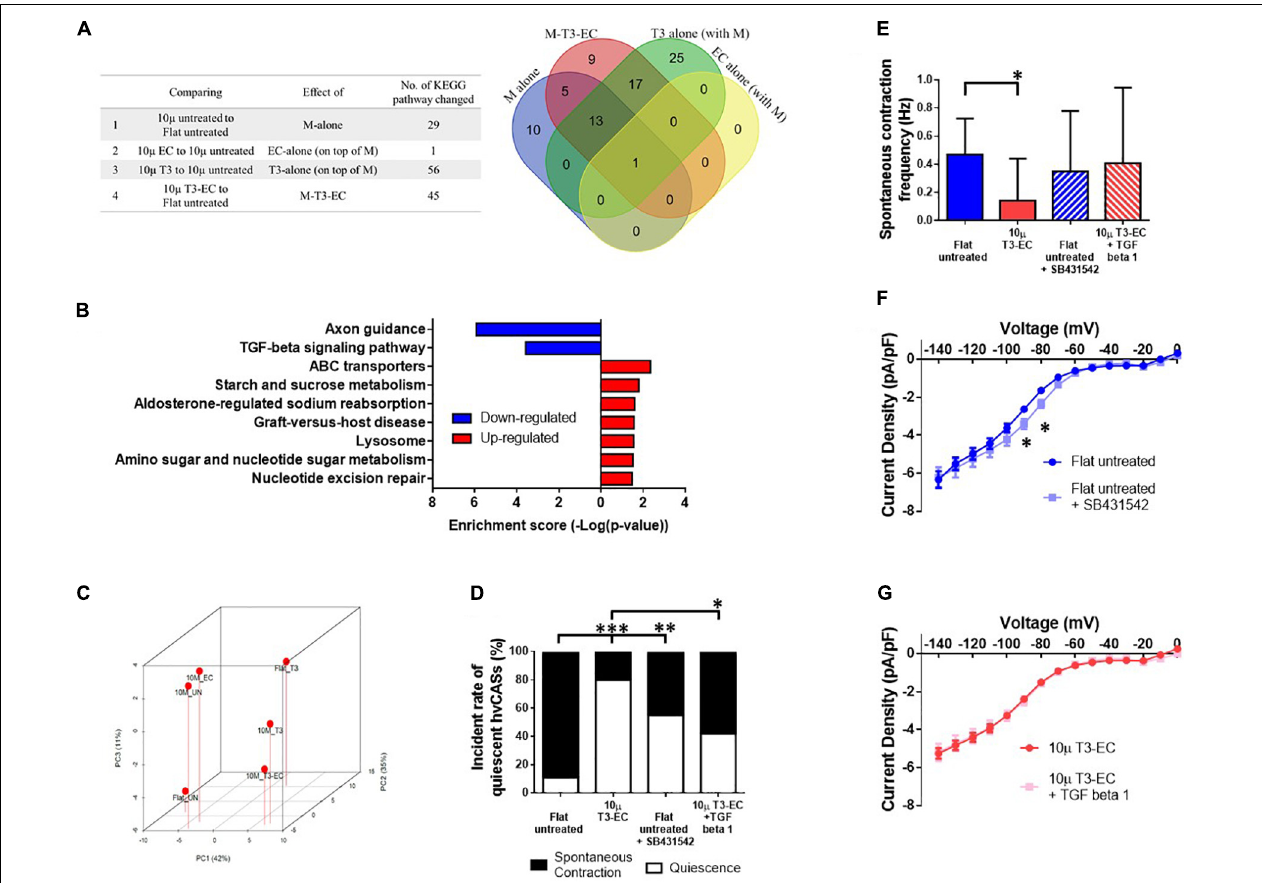
FIGURE 5 | TGF- β signaling pathway downregulation is associated with T3-EC-induced quiescence. (A) The list and the corresponding Venn diagram showing the significant changed pathways of different conditions and combinatorial treatment by the KEGG pathway database. (B) The enrichment score of the KEGG pathways significantly changed. (C) The principal component analysis (PCA) showing the relative relationship of TGF- β signaling pathway expression level of each groups. The relationships of SB431542 and/or TGF- β 1 in flat untreated and 10 µ T3-EC hvCAS, respectively. (D) The incident rate of quiescent hvCAS. (E) The spontaneous contraction frequency of hvCAS (three batches of independent differentiations, n = 14–18 for each group). (F,G) The steady-state I–V relationships of I f from flat untreated and 10 µ T3-EC with SB431542 and TGF- β 1, respectively (two–three batches of independent differentiations, n = 10–16). (D) Chi-square test. (E) One-way ANOVA test, followed by Dunnett multiple comparison test to flat untreated control. (F,G) Two-tailed unpaired t -test. ∗ p < 0.05, ∗∗ p < 0.01, and ∗∗∗ p <